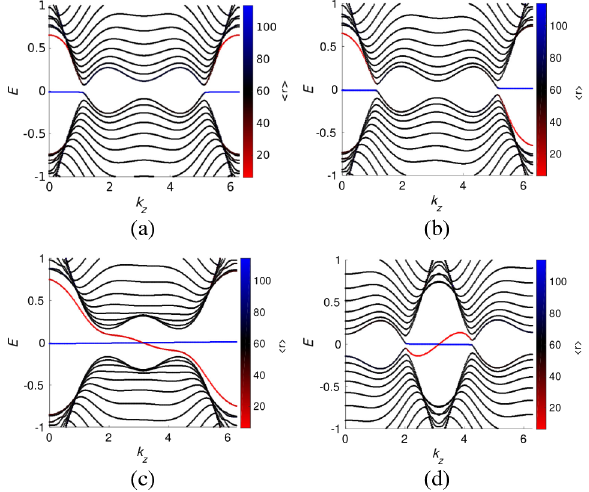
FIG. 7. Band structure of the lattice regularized version of Eq. (64) in a cylindrical geometry. Color corresponds to h r i with the dislocation at r ¼ 0 ; red indicates localization on the dislocation, and blue is localization on the outer boundary. Para- meters are M 0 ¼ 0 , M 1 ¼ 0 . 342 eV Å 2 , M 2 ¼ 18 . 25 eV Å 2 , L 1 ¼ 1 . 33 eV Å, L 2 ¼ 2 . 82 eV Å, R ¼ 120 radial sites, and l ¼ 1 = 2 angular momentum unless otherwise stated. Note that because of the dislocation, the system is not periodic in k fixed angular momentum. (a) WSM phase ( U 0 ¼ 1 . 3 eV), no dislocation. (b) Same as (a), but with dislocation. (c) Axion insulator phase ( U 0 ¼ 1 . 7 eV) with dislocation. (d) WSM phase topologically nontrivial BZ slices centered at k